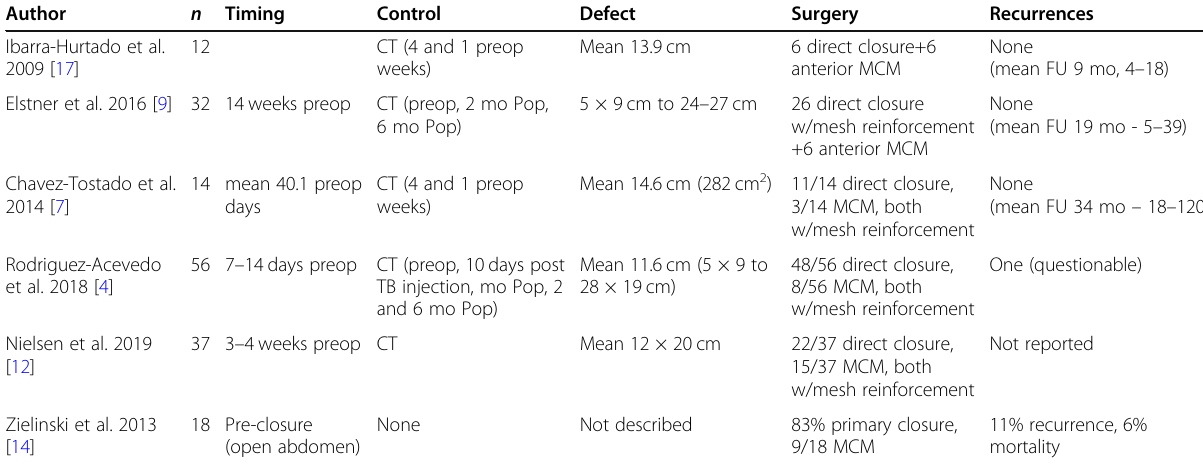
Table 3 BTI to treat CIH: